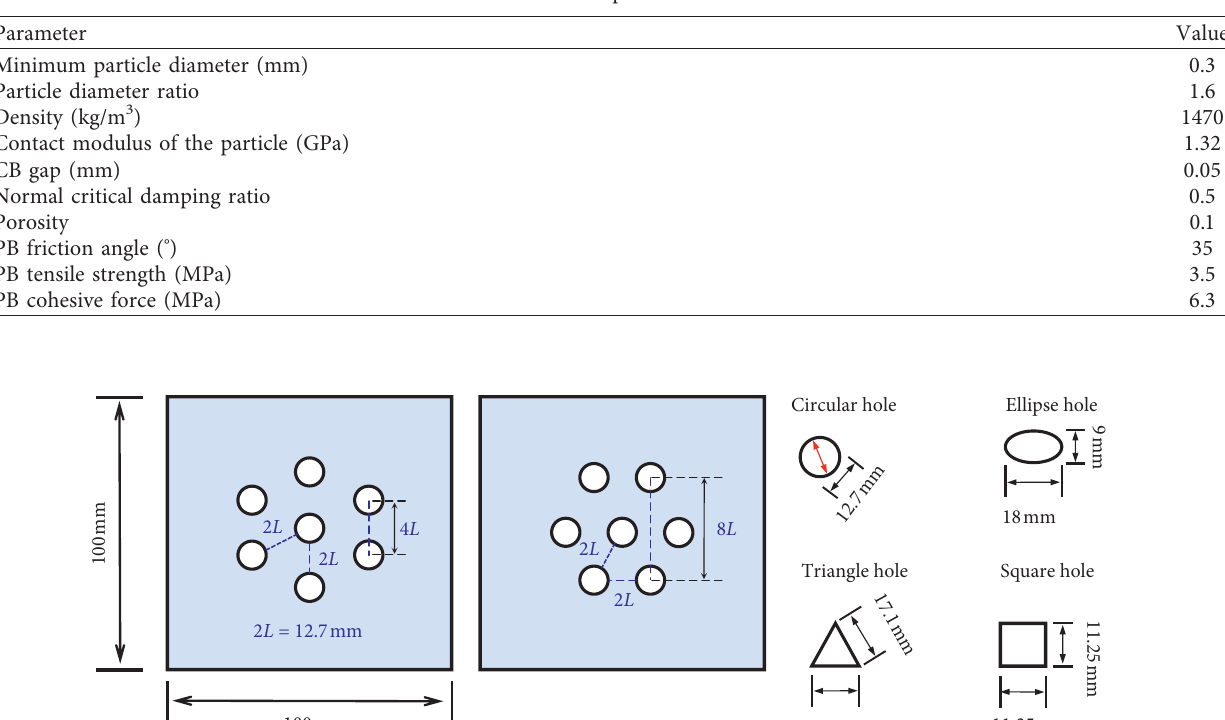
Figure 3: Numerical simulation parameter check. Table 1: Micromechanics parameters based on PFC.